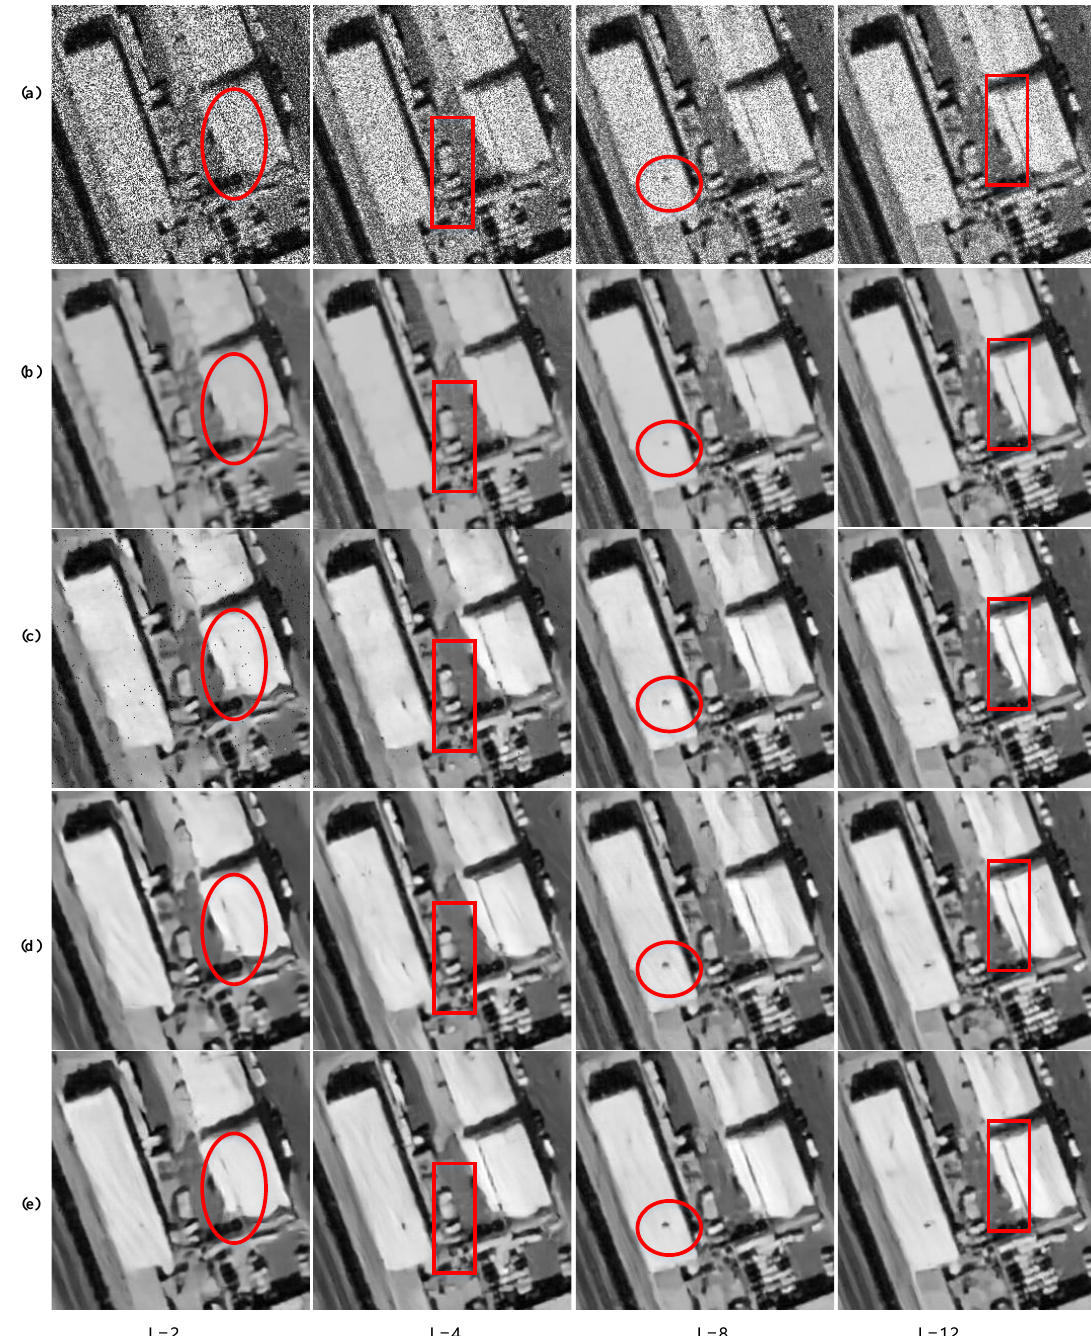
Figure 9. Test results on images of buildings with four levels of noise. The noise level from left to right is L = 2, L = 4, L = 8, and L = 12. ( a ) Speckled image ( b ) SAR-BM3D ( c ) ID-CNN ( d ) RED-Net ( e )